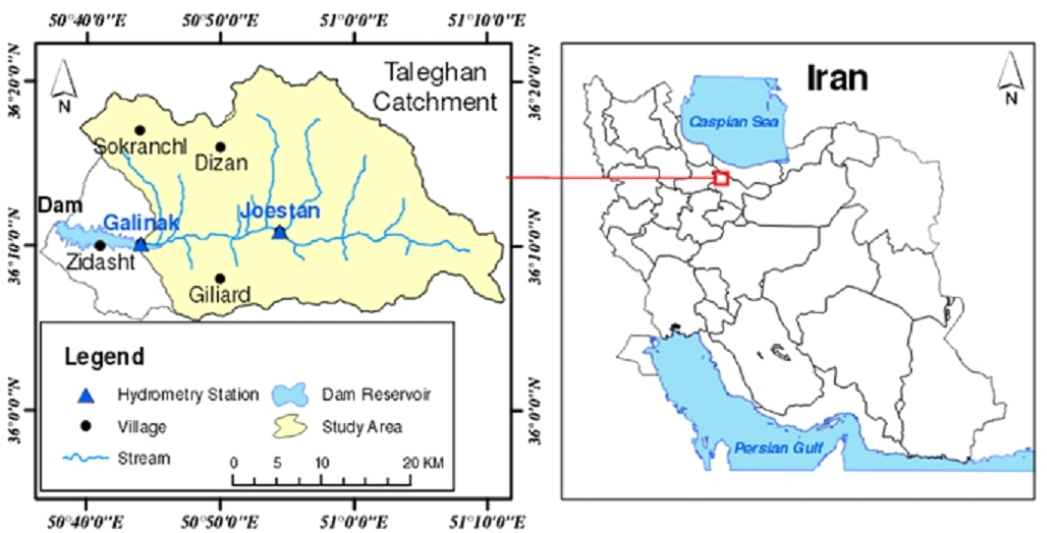
Fig. 1: A schema on the location of Taleghan Dam in Taleghan Basin and in Iran (Hosseini et al., 2012)